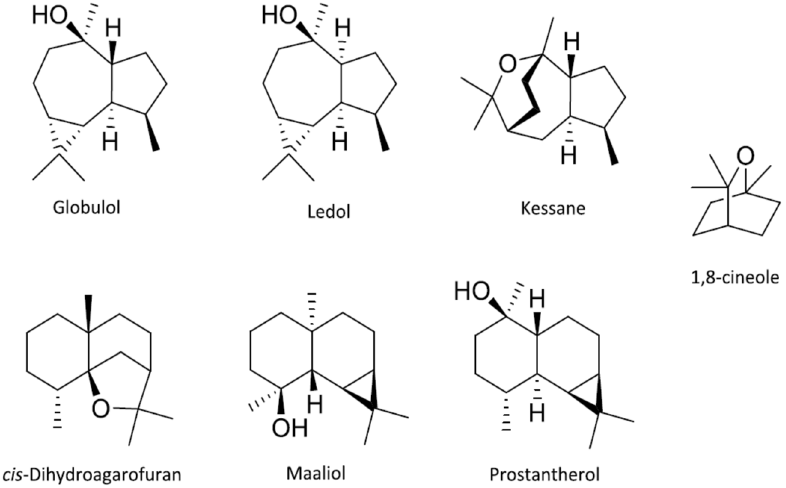
Figure 1. Major sesquiterpenes and 1,8-cineole in the Prostanthera ovalifolia heterogeneous species aggregate.